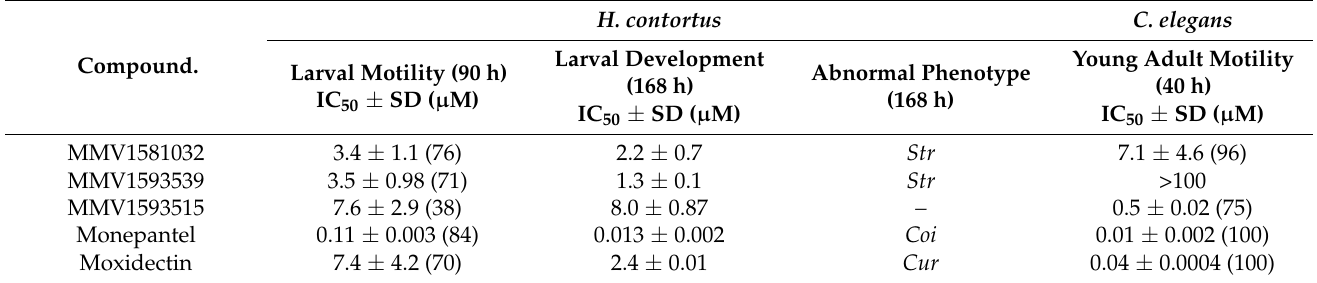
IC 50 calculated from three independent assays conducted in triplicate. Value in parentheses represents the maximum motility inhibition (%). Str , straight; – , no apparent distinction from wild-type, but reduced motility; Coi , coiled; Cur , curved.